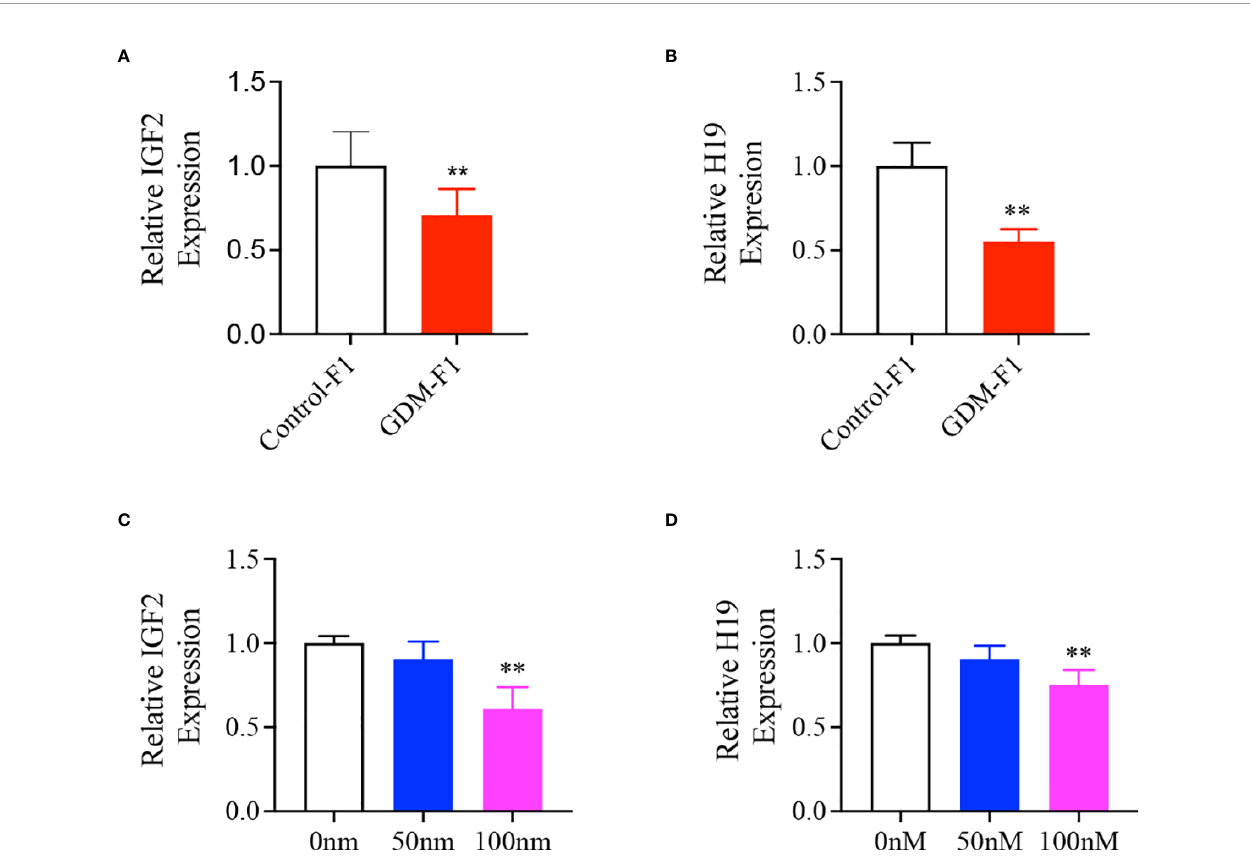
FIGURE 3 | Representative mRNA levels of Igf2, H19 in the liver of 8-week-old F1 male mice and HepG2 cells treated with different insulin concentration. (A, B) IGF2/H19 mRNA expression in the liver of 8-week-old mice (every group contains 10 mice); (C, D) IGF2, H19 gene expression in HepG2 cells treated with 0, 50, 100 mnol/L insulin concentration (n = 4 replicates/group in at least three independent isolations). Data were analyzed with the Eq. 2 - DD CT where DD CT = D CT (treatment group) - D CT (control group), and D CT = D CT (sample) - D CT (intemal control). The values were normalized to ACTIN mRNA levels, ACTIN was an intemal control. Data are presented as mean ± SD, * P < 0.01. Signi fi cance was determined by Student t